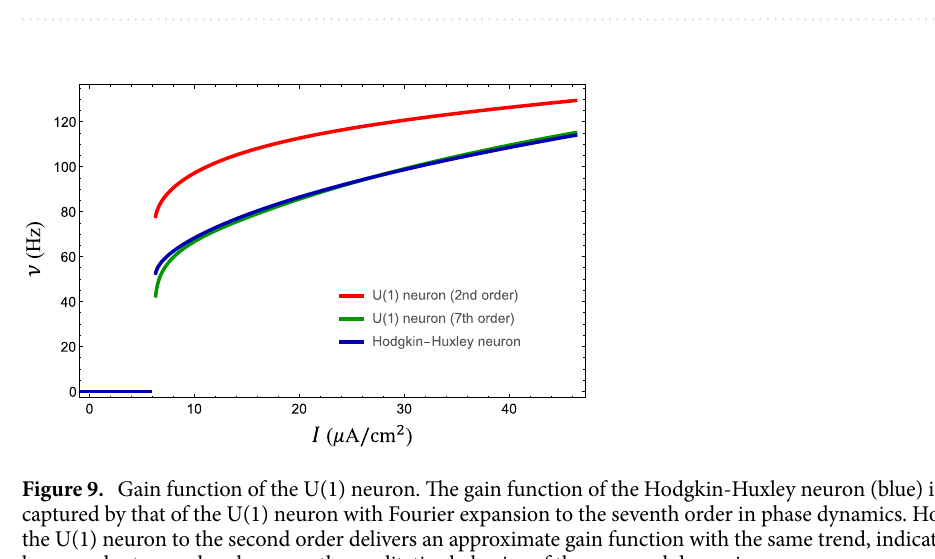
Figure 8. The action potentials of ( A ) the effective U(1) neuron and ( B ) the Hodgkin-Huxley neuron are almost identical. The external current is I = 26.28 µ A/cm 2 for both neurons. The voltage of the resting state V rest = − 65 mV is shifted to zero for visual clarity.